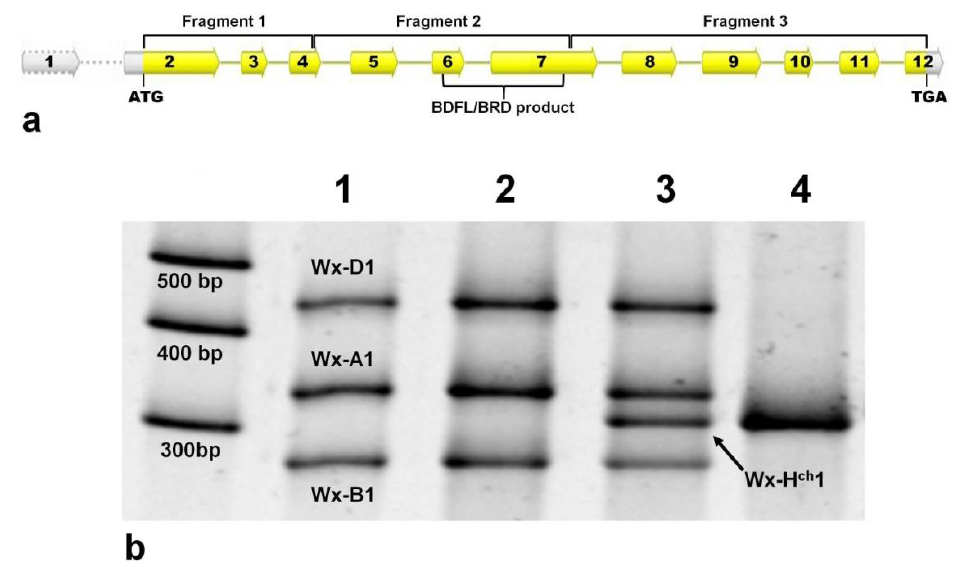
Figure 1. ( a ) Diagrammatic representation of Wx gene showing the three fragments used for sequencing, and ( b ) PCR analysis for the chromosomal location of H. chilense Wx gene using primers BDFL / BRD from Nakamura et al. [33] in common wheat, ditelosomic addition lines, and H. chilense . Lanes are as follows: 1, cv. Chinese Spring (CS), 2, CS + 7 H ch S line, 3, CS + 7 H ch L line, and 4, H 1 line.